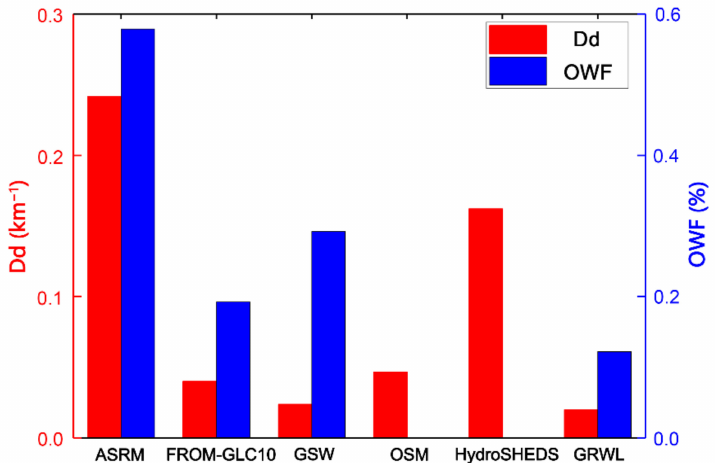
Figure 12. Comparison of ASRM with other data products for Dd and OWF.